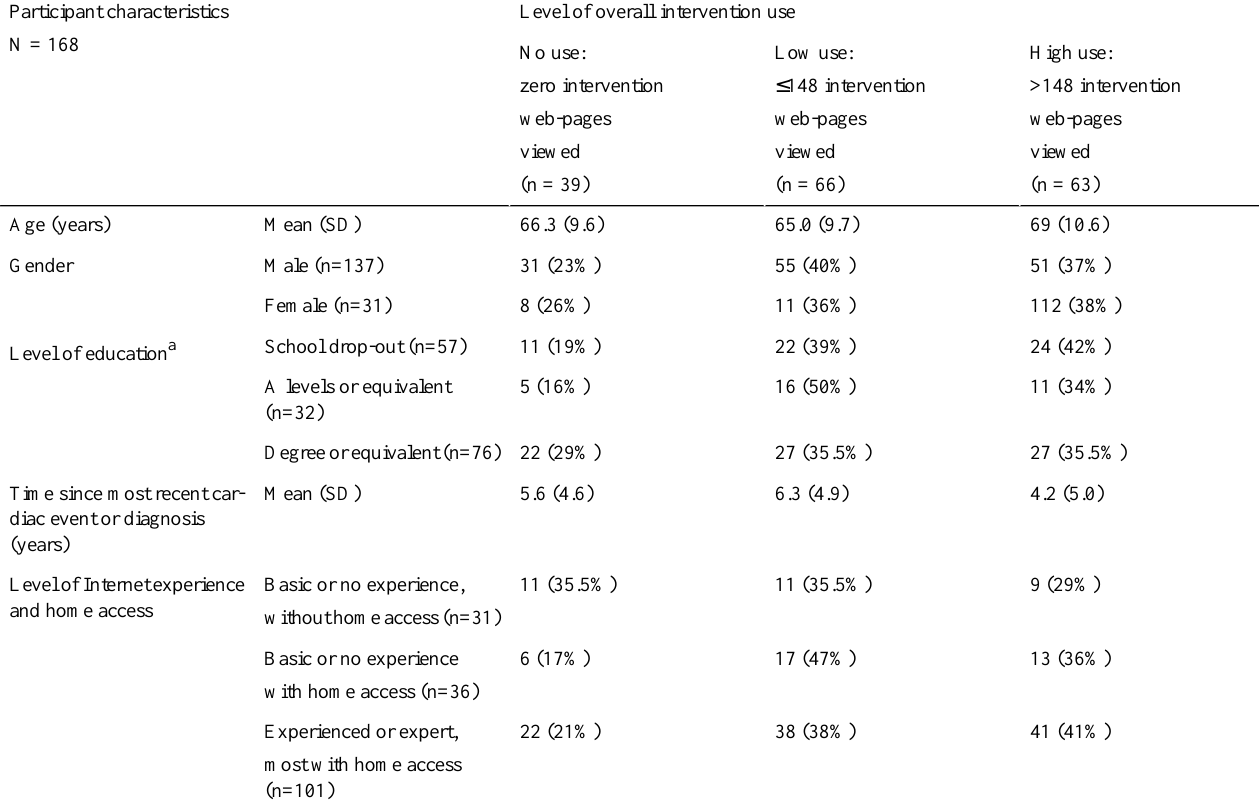
Table 2. Characteristics of participants by level of intervention use